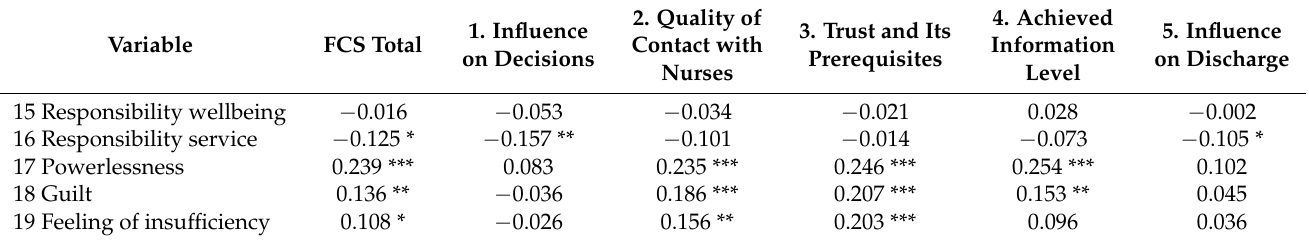
Table 4. FCS total and subscale results regressed on the family member’s feelings in relation to the older